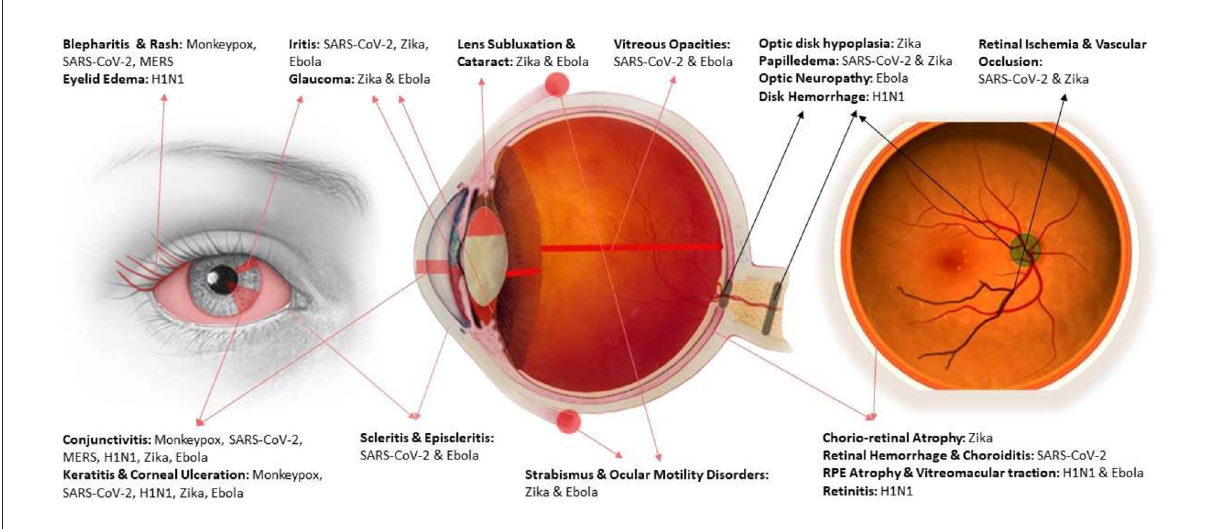
FIGURE2 An illustration for affected structures by each viral disease